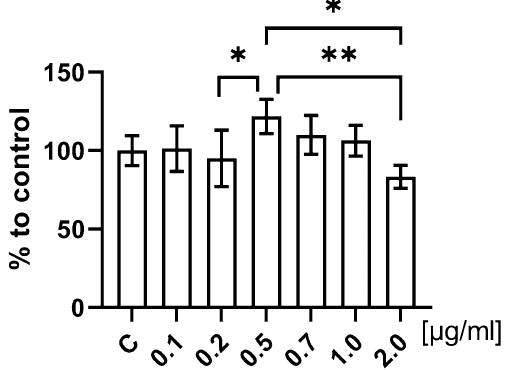
Figure 1. LESC viability based on the measurement of mitochondrial oxidative activity with MTT assay after exposure to LPS. The bars represent the means ± standard deviation (SD) of the percentages of the control group (fold to 100%); ANOVA with the Tukey post hoc test, *p < 0.05, **p <